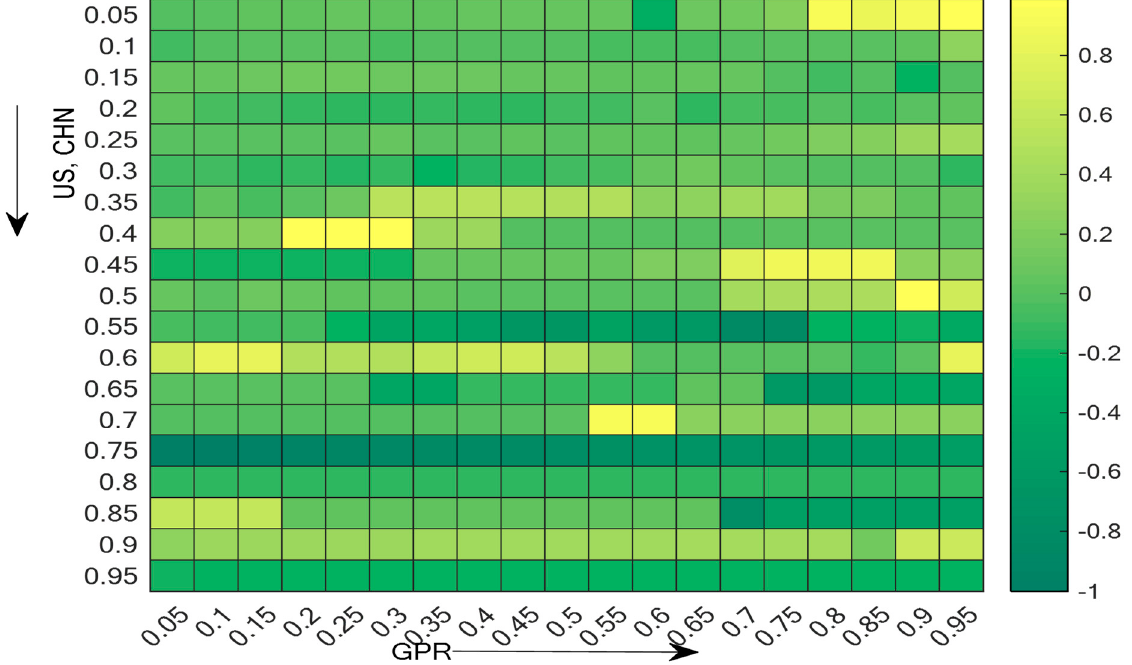
Figure 7. The response of US–CHN stock market synchronization to geopolitical risk. Note: The horizontal axis indicates the quantile of GPR, whereas the vertical axis is the quantile of stock market synchronization in ascending order. The right-side color bar indicates the intensity of the response of synchronization to GPR. The dark green and yellow colors indicate negative and positive responses and synchronization to GPR, respectively.